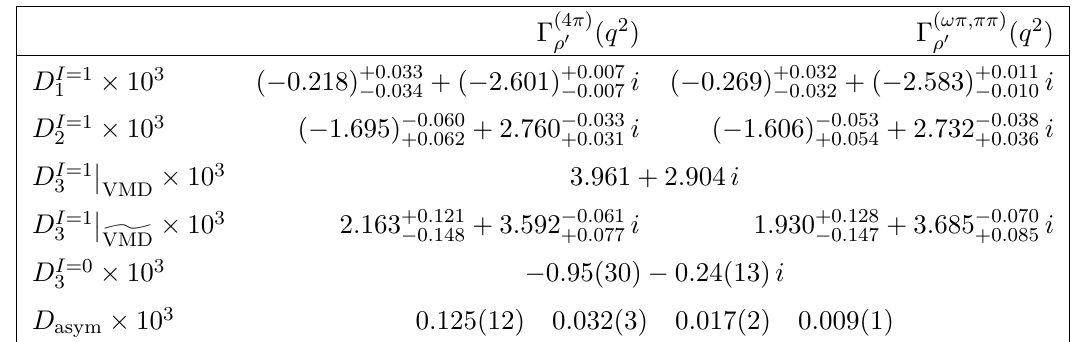
; here, we show the special 1 / 2